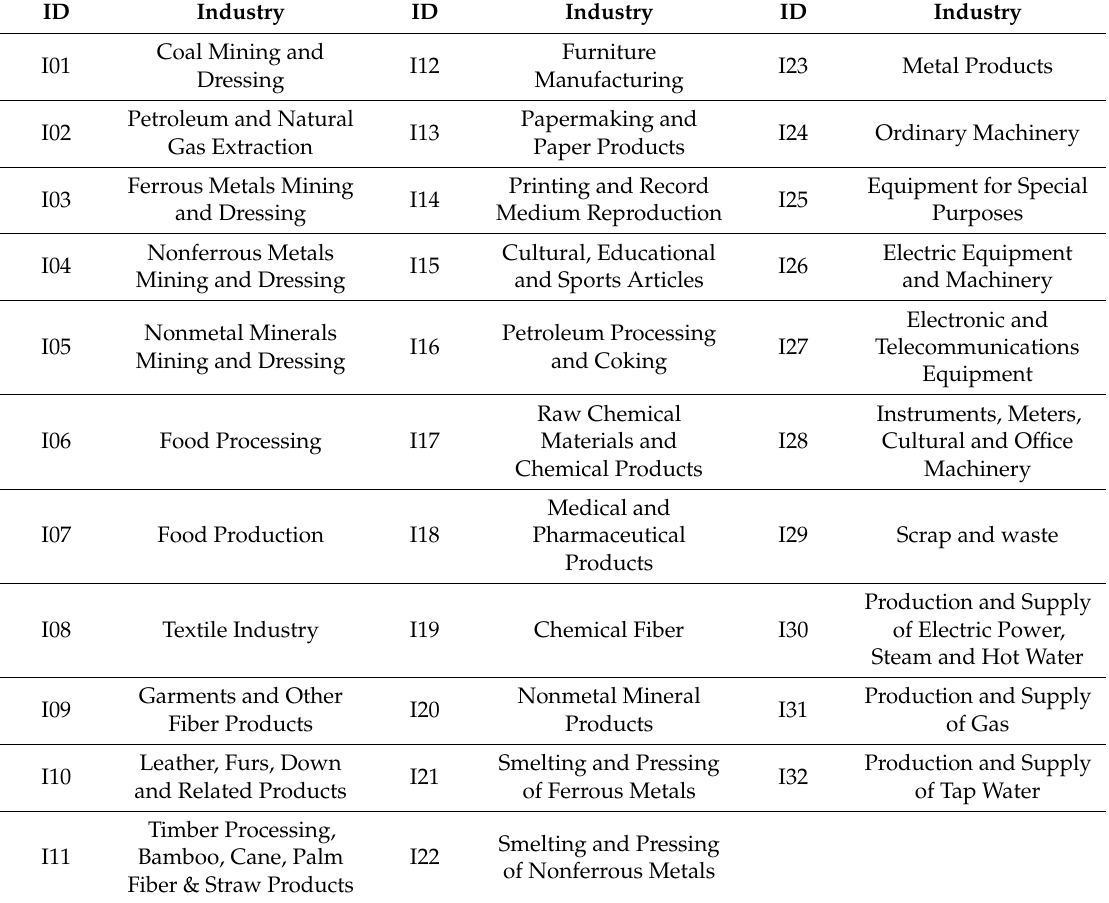
Table 2. Industry ID marking